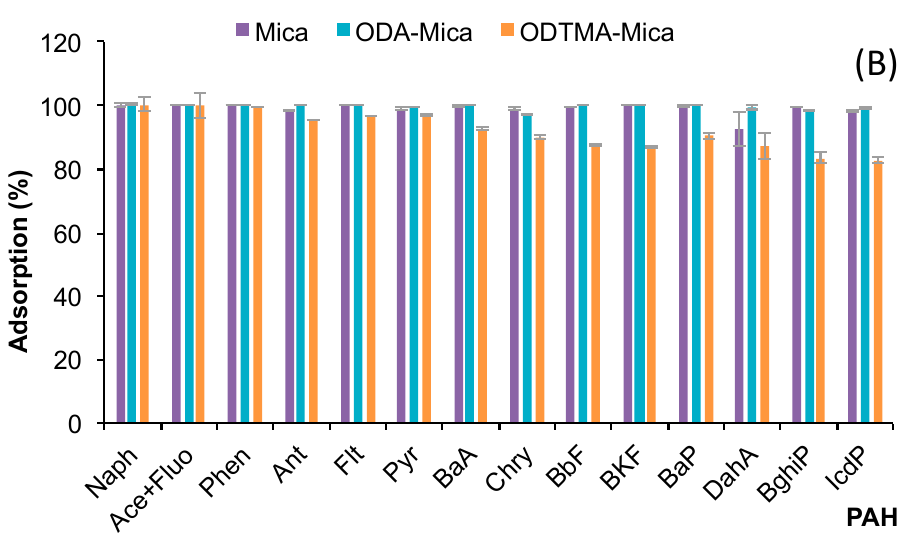
Figure 4. PAHs adsorption (%) on Mt and organofunctionalized derivatives ( A ) and Na-Mica-4 and organofunctionalized derivatives ( B ).